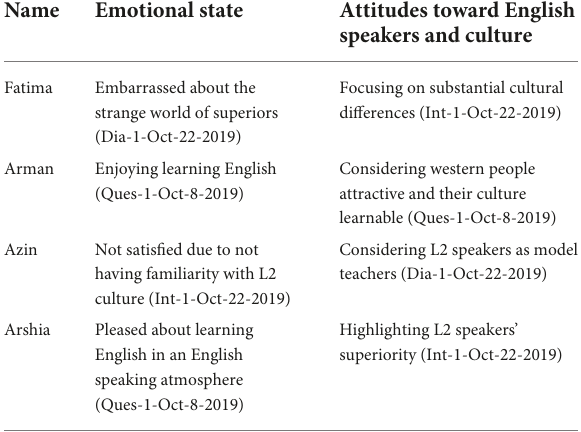
TABLE 3 Participants’ recollecting self-descriptions of the initial phases of learning